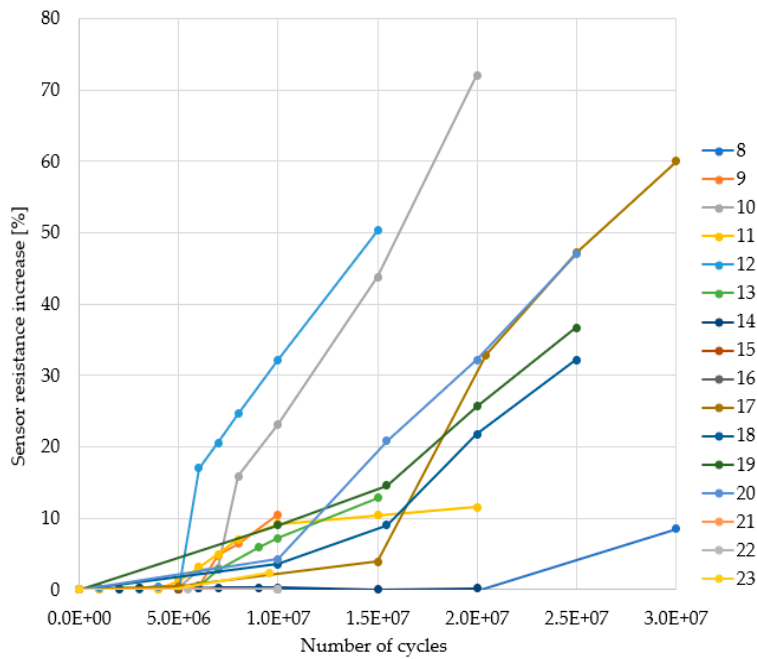
Figure 15. Sensor response for chips tested with 100%AA.